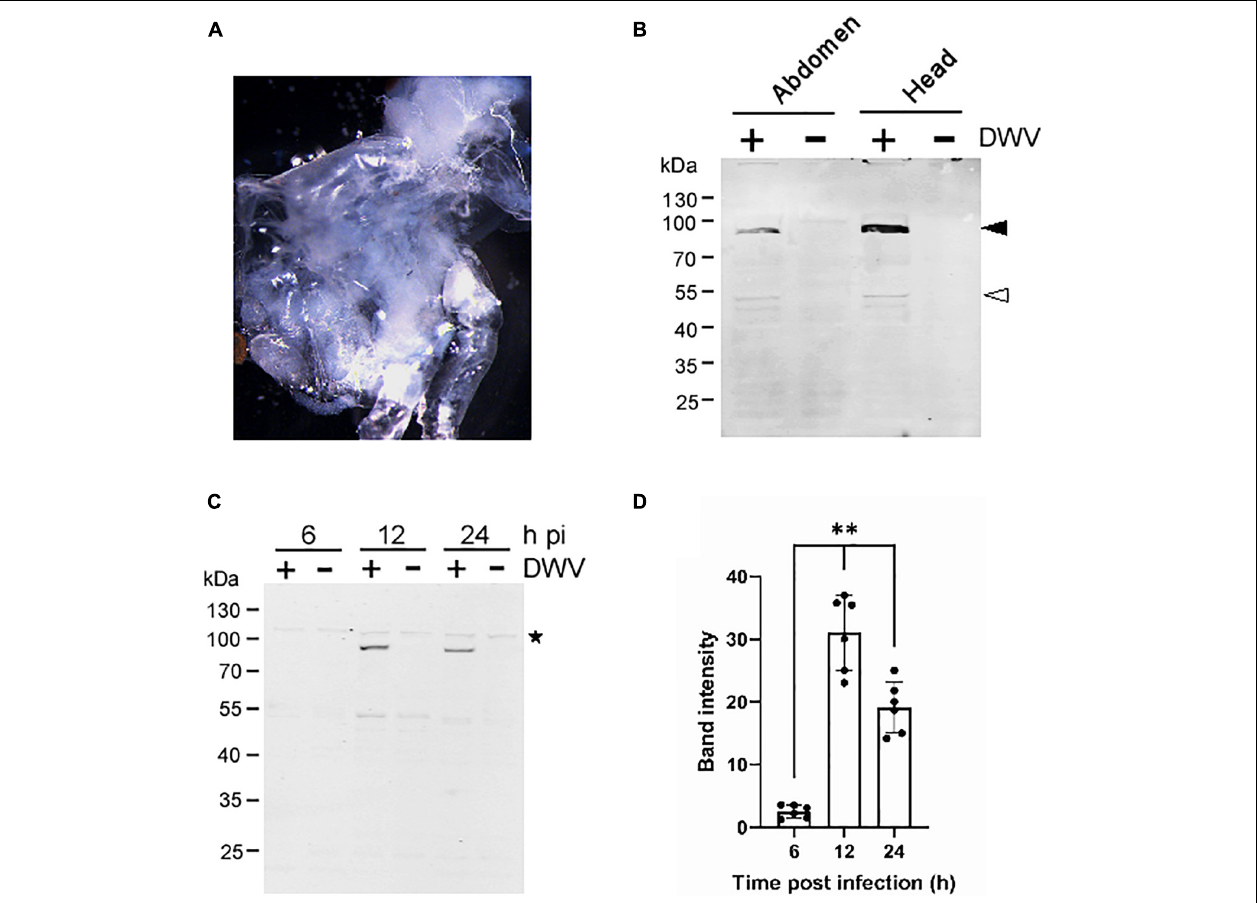
FIGURE 1 | Infection of honey bee pupal tissues with DWV. (A) Image of the cultured head tissue from pale eyes-pupa. (B) Abdomen or head of the single pupa was sagittally halved and one tissue was infected by DWV (+) whereas the other was left untreated ( − ). DWV infection was tested through western blotting using anti-RdRP antibody. RdRP precursor with 3C-protease (90 kDa) and mature RdRP (53 kDa) bands are indicated with black and white arrowheads, respectively. The molecular weight (kDa) of the protein marker is at the left. (C) Synthesis of RdRP in the pupal head tissue was tested at 6, 12, and 24 h after DWV infection (hpi). The star represents a protein that non-specifically cross-reacted with anti-RdRP antibody. The presence of this band indicates that an equal amount of protein was loaded in each lane. (D) Band intensity of the RdRP precursor was compared between three time points using the one-tailed Dunnett test and P -values between 6 and 12 or 24 h are < 1.3 × 10 − 6 and < 7.2 × 10 − 6 , respectively (**). Mean values ± SD (error bars) are shown ( n = 6). *This represents statistical